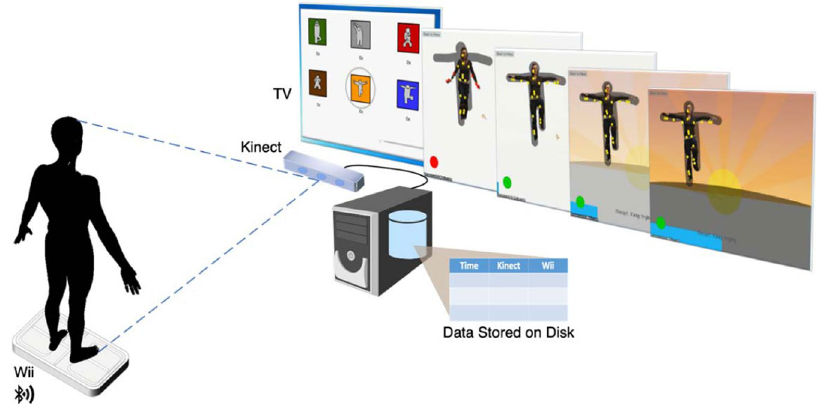
Figure 1. Study setup. Microsoft Kinect camera and Wii Balance Board send the joint kinematic and postural sway data to the computer, which controls the biofeedback-based balance training game and records the data.